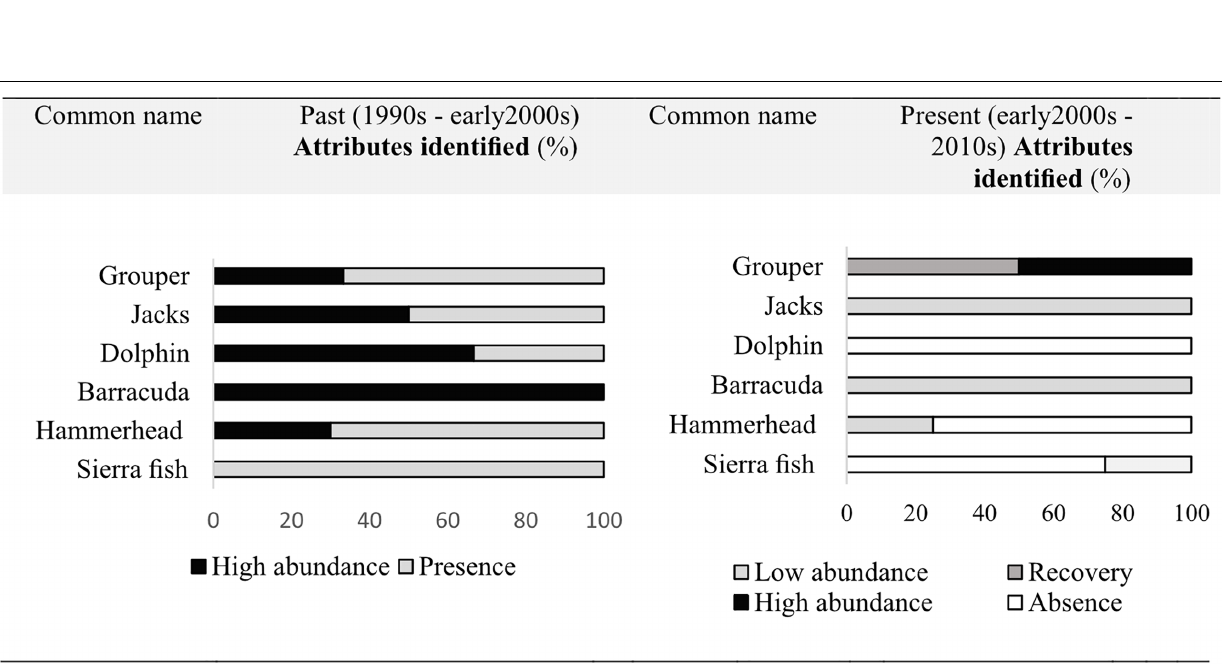
Frontiers in Marine Science |